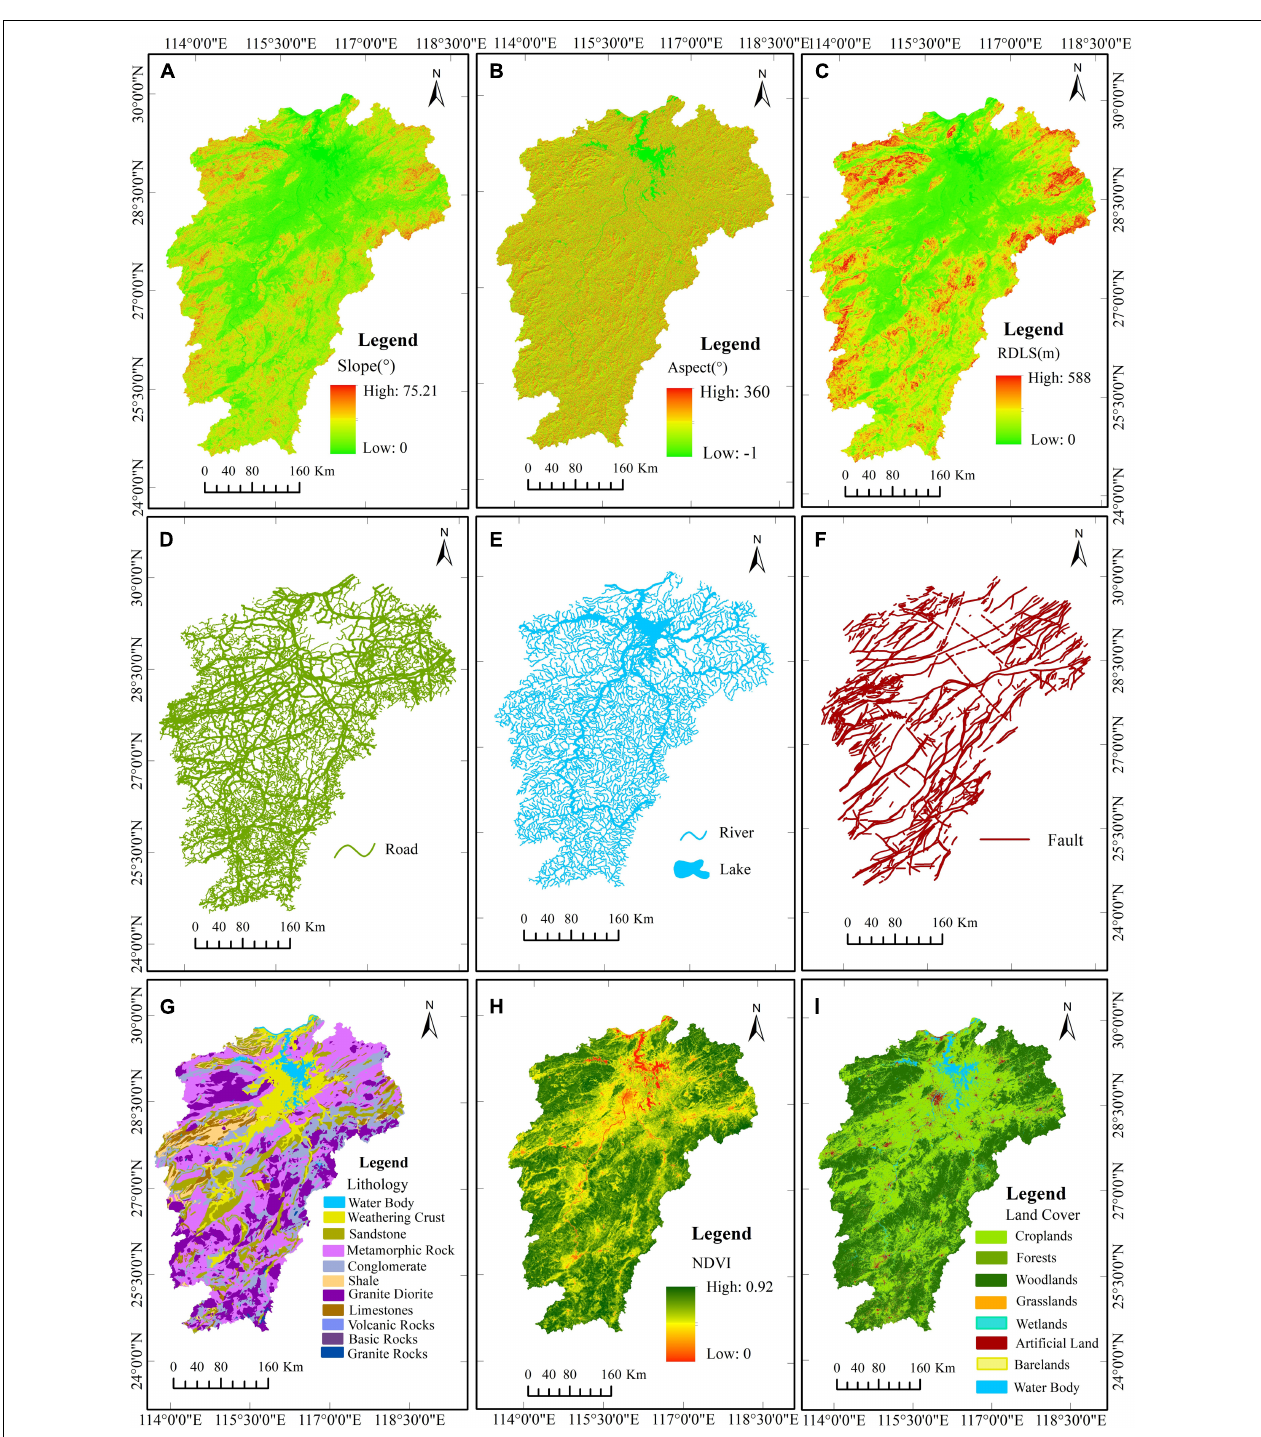
FIGURE 3 | Landslide proneness factors used in this research, taking the following as an example: (A) slope, (B) aspect, (C) RDLS, (D) roads, (E) rivers, (F) faults, (G) lithology, (H) NDVI, and (I) land cover.